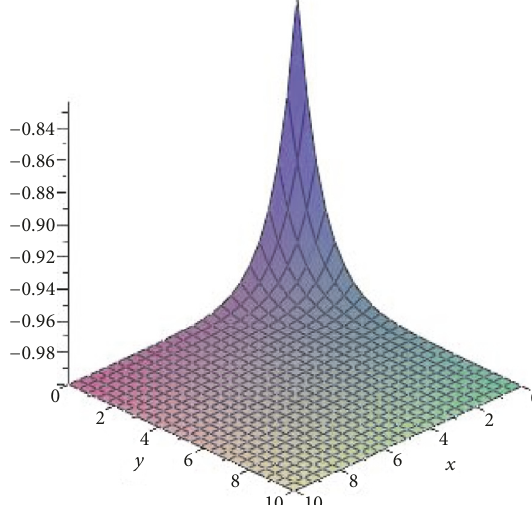
Figure 1: The solitary wave solution 𝑢 6 with 𝛼 = 0.5 , 𝐹 1 (𝑐𝑦+𝑇) = 1 , 𝐹 (𝑐𝑦 + 𝑇) = cy + T, c = 𝜆 = 1 , 𝑡 = 3 . 2